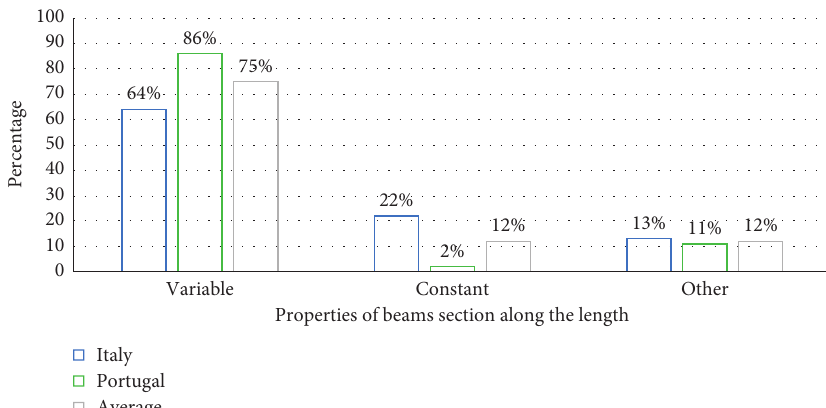
Figure 28: Comparison of beams cross-section of precast RC buildings in Portugal and Italy (Emilia-Romagna).